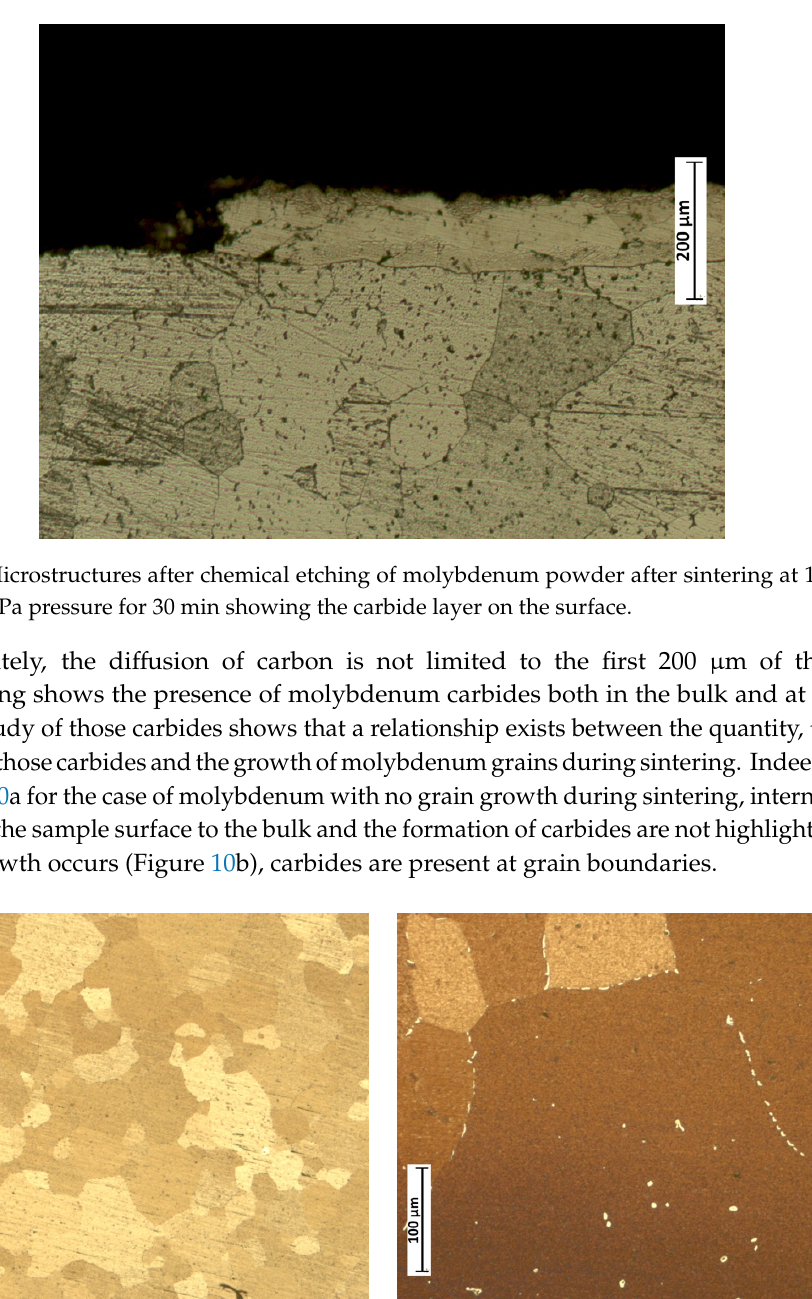
Figure 9. Microstructures after chemical etching of molybdenum powder after sintering at 1900 °C under 70 MPa pressure for 30 min showing the carbide layer on the surface.